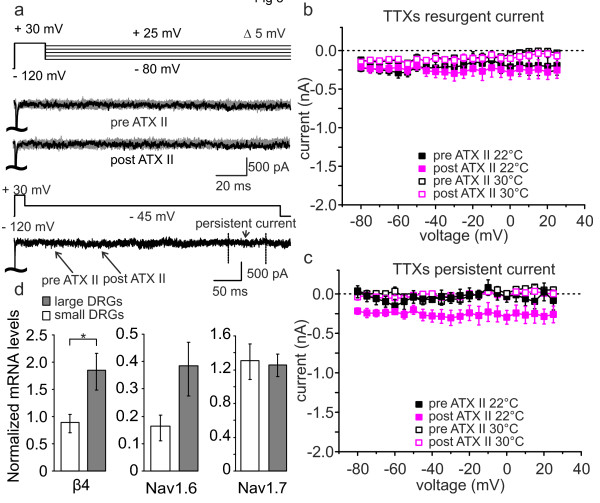
Small diameter DRGs are unaffected by ATX-II or increased temperature. (a) The same stimulation protocol as used in large diameter DRGs was applied to small DRGs (upper lane). Example traces of TTX-s sodium currents pre and post 5 nM ATX-II application are shown. Lower lane displays an overlay of pre and post ATX-II traces at a voltage of −45 mV. (b) TTXs peak current at the time point at which resurgent currents would be expected as a function of voltage in small diameter DRGs. Neither at 22°C (filled symbols, n = 7) nor at 30°C (open symbols, n = 4) a significant ATX-II- induced resurgent current is evident (paired-sample T-test). (c) Mean persistent current as a function of voltage pre (black symbols) and post (pink symbols) ATX-II application. In small diameter DRGs there is no significant increase in persistent current detectable due to ATX-II exposure or heating to 30°C (paired-sample T-test). (d) Expression levels of β4, Nav1.6 and Nav1.7 mRNA normalized to the mean of two house-keeping genes in FACS-sorted small (white bars) and large (grey bars) DRGs determined by RT-qPCR. In large DRGs ß4 and Nav1.6 expression is twice as high compared to small neurons. On the contrary, Nav1.7 mRNA is evenly expressed in small and large DRGs (n = 3; * p < 0.05).